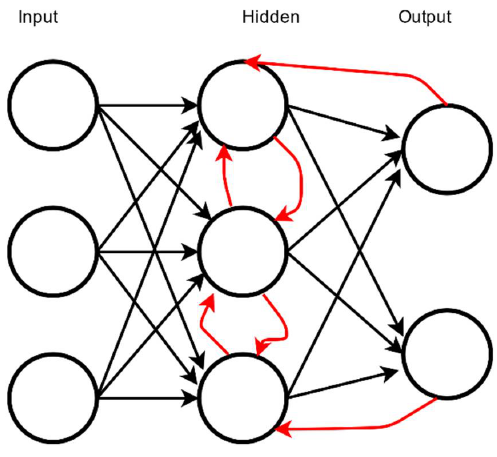
Figure 10. The architecture of LSTM Network [99]. Table 1. The tabular analysis of the deep learning algorithms reviewed in this article. A. R.